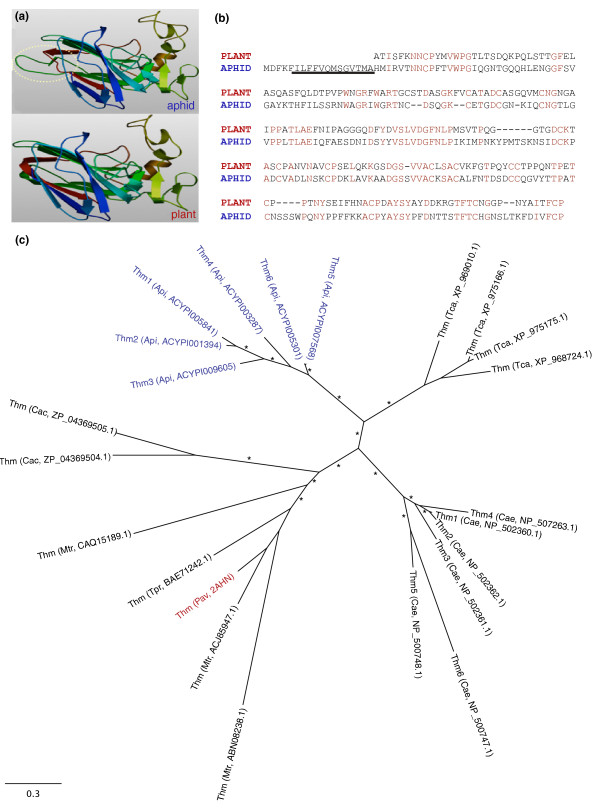
Evolutionarily conserved thaumatins are present in pea aphids and plants. (a) The three-dimensional structure of the pea aphid thaumatin ACYPI009605 (top) was calculated using the published crystallographic structure of a sweet cherry (plant) thaumatin 2AHN_A (bottom) [130] and Swissmodel [131], revealing that both thaumatins are similar in structure. However, one exposed loop, encircled by a dotted line, shows a significant difference in structure, suggesting possible adaptation to different targets. (b) Similarities are also revealed in the alignment of the pea aphid thaumatin with the plant thaumatin. A predicted signal sequence of the pea aphid thaumatin is underlined. Identical amino acids are highlighted in red. (c) Maximum likelihood phylogeny of thaumatins, indicating branches leading to nematode, plant, insect and bacteria-specific clades. Red highlights the sweet cherry thaumatin. Blue highlights the pea aphid thaumatins. Asterisks indicate approximate likelihood ratio test support >80. Abbreviations: Api, A. pisum; Cac, Catenulispora acidiphila; Cel, Caenorhabditis elegans; Mtr, Medicago truncatula; Pav, Prunus avium; Tca, Tribolium castaneum; Tpr, Trifolium pretense.